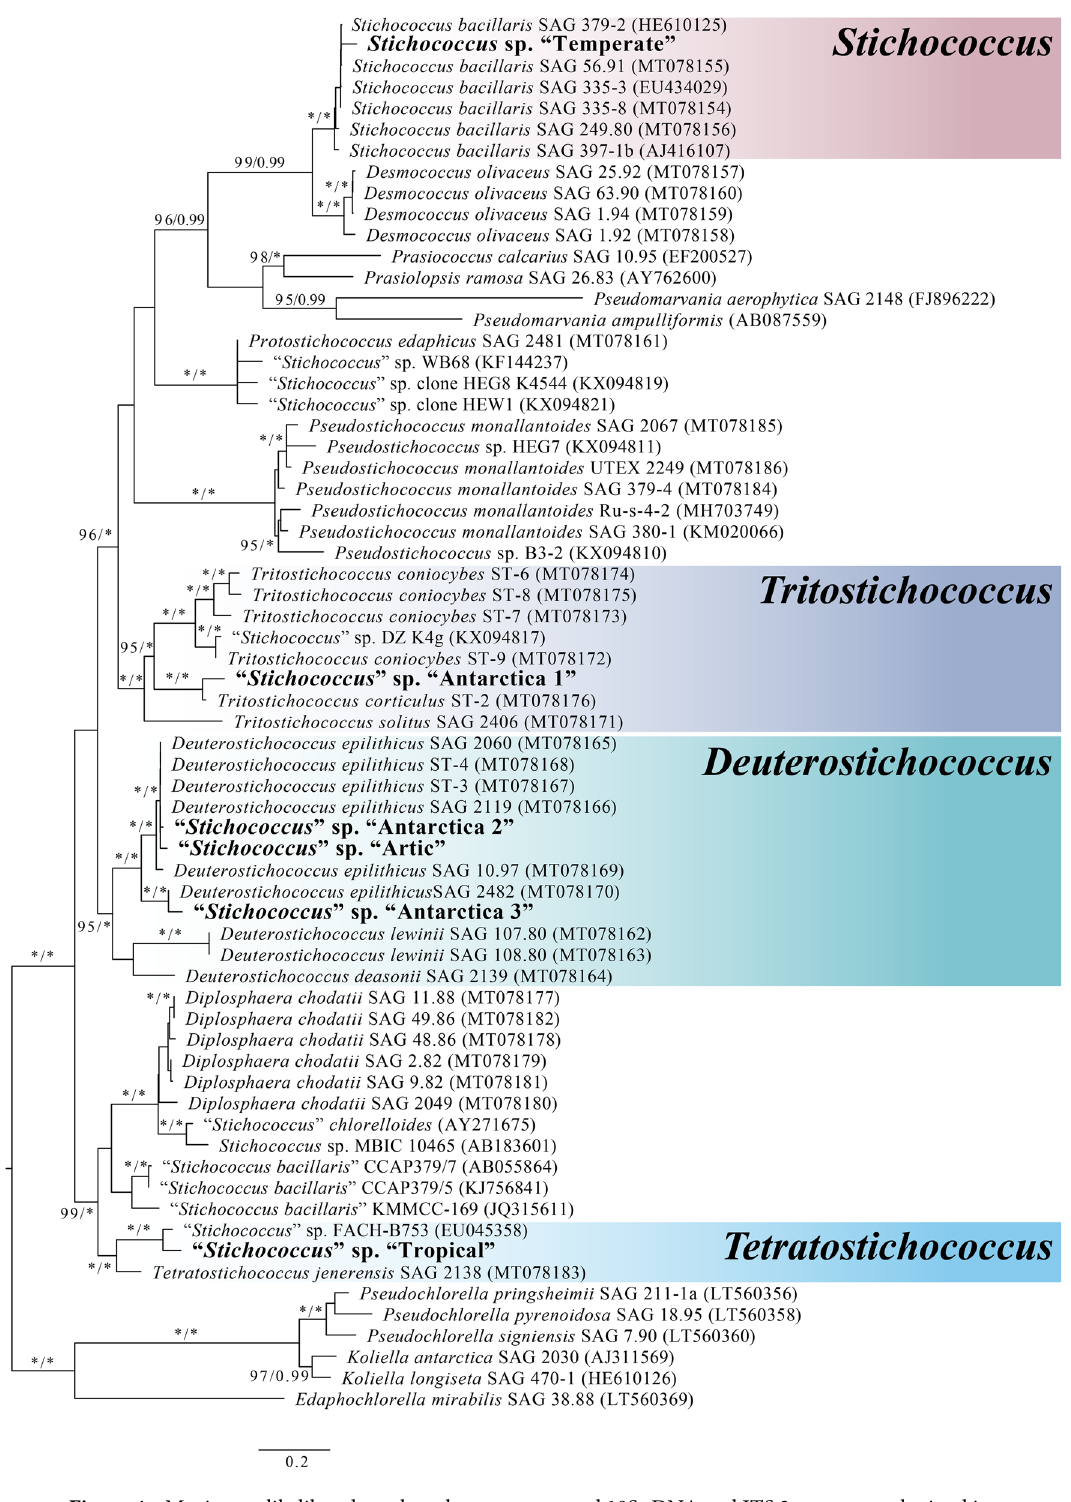
Figure 4. Maximum-likelihood tree based on concatenated 18S rDNA and ITS 2 sequences obtained in this study (in boldface). Numbers next to branches indicate statistical support value (maximum likelihood bootstrap/Bayesian posterior probabilities). Chlorella -like algal strains including Pseudochlorella , Koliella and Edaphachlorella were used as the outgroup. Scale bar represents 0.2 changes per